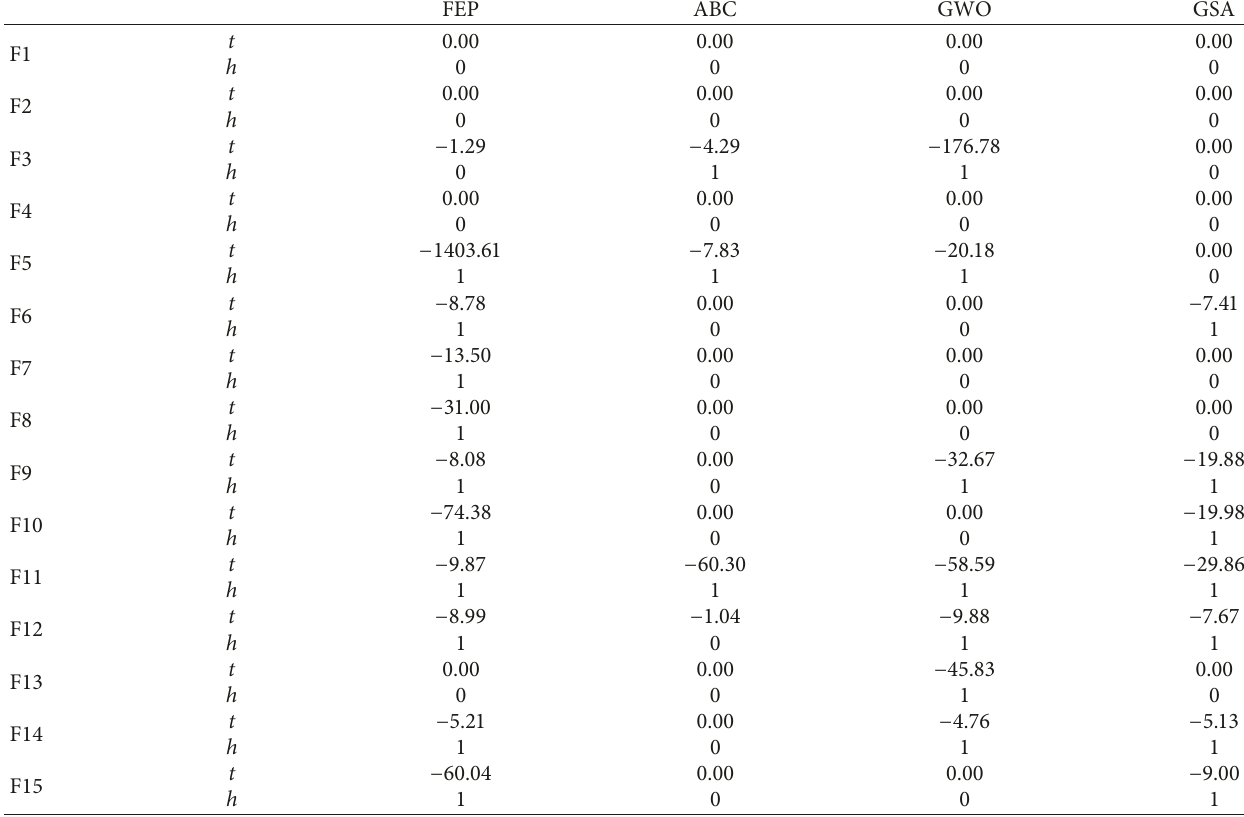
Table 11: t-value and h-value comparison with FEP [15], ABC [29], GWO [7], and GSA [30].